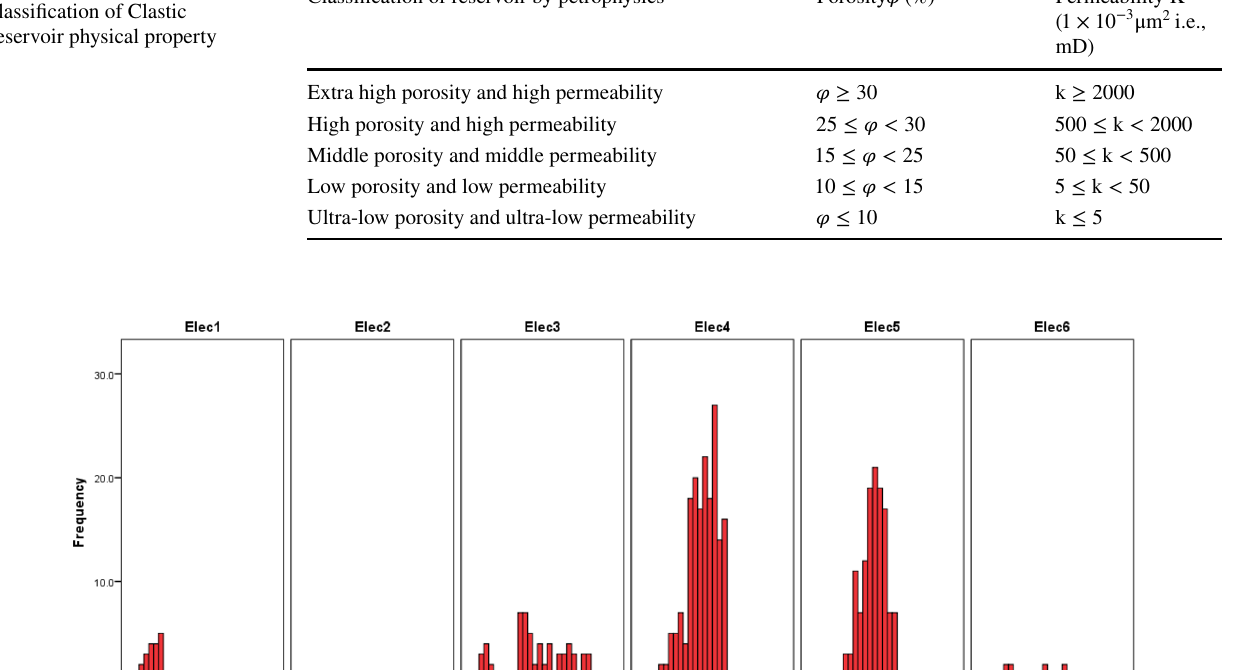
Classification of reservoir by petrophysics